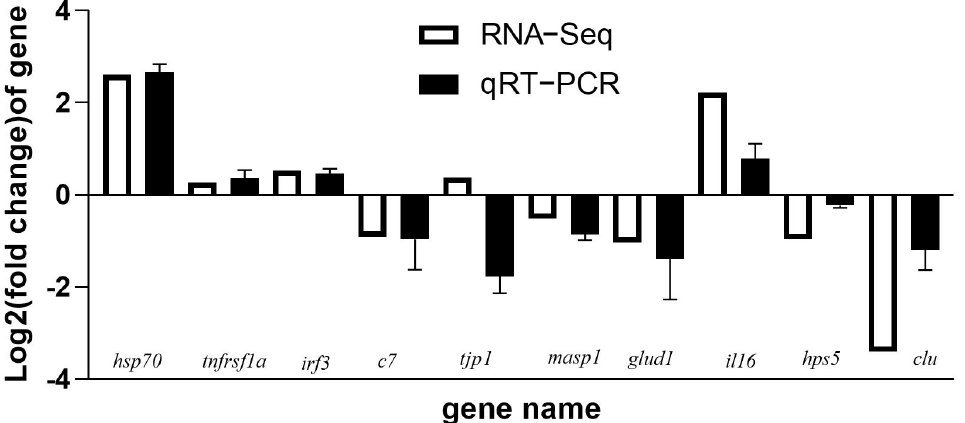
Figure 8. Comparison of mRNA expression changes between RNA − Seq and RT − qPCR of S. sihama liver. Fold change shows the expression level of mRNA in the R64 group compared with the FM group (n = 3). The relative expression values were normalized to EF − 1 Alpha gene expression. Error bars indicate standard